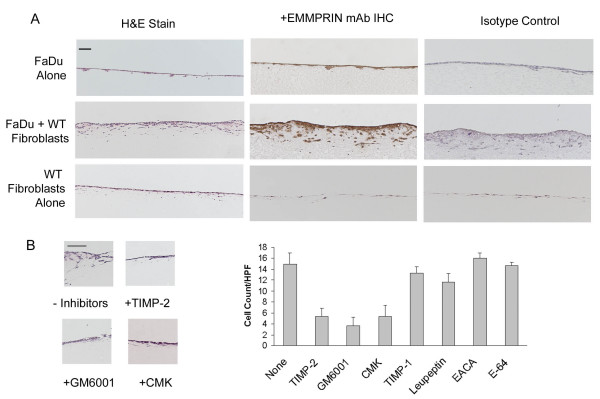
Coculture of FaDu tumor cells and wild-type (WT) fibroblasts induces MMP-dependent tumor cell invasion. WT fibroblasts were cultured in a 2:1 ratio with FaDU HNSCC tumor cells atop Type I collagen for 6 days. EMMPRIN immunoreactivity identified invading tumor cells (A). Protease inhibitors were added to assess the role of MMPs in the invasive program (B). FaDu-WT fibroblast invasion was sensitive to synthetic (GM6001, 20 uM) and endogenous (TIMP2, 10 nM) broad spectrum MMP inhibitors and to furin inhibition (synthetic peptidyl chloromethyl ketones, CMK, 50 uM), but not TIMP-1 (10 nM), serine protease inhibitors (leupeptin, 10 uM; epsilon-amino-caproic acid (EACA), 10 mM) or cysteine protease inhibitors (E64, 10 ug/ml). Bar, 100 μm.